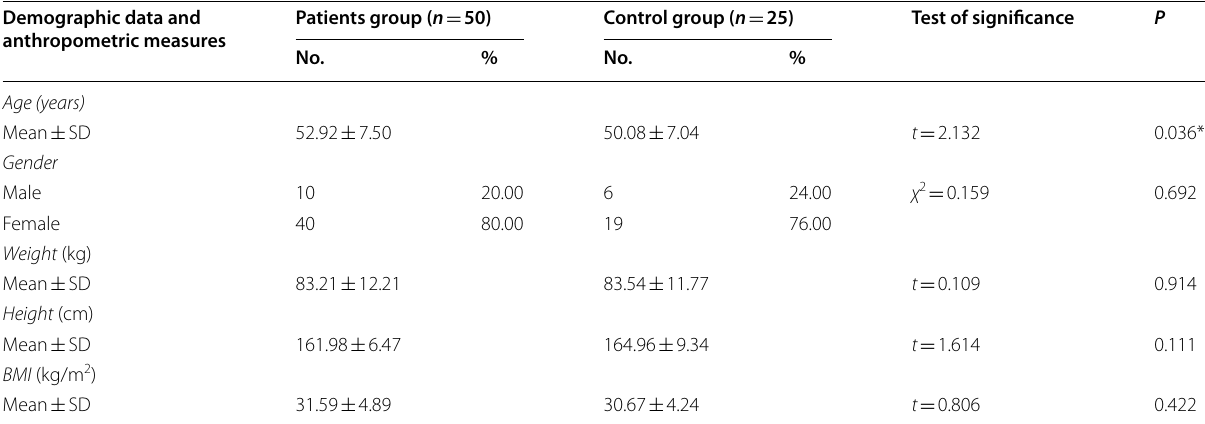
Table 1 Comparison between patient and control groups according to demographic data and anthropometric measures